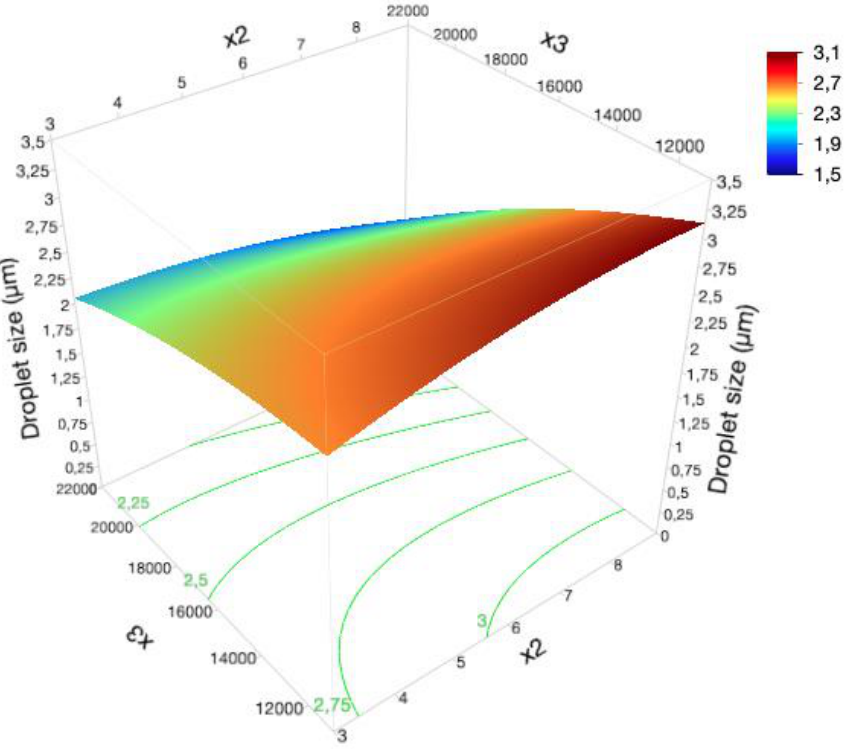
Figure 1. Response surface plot showing the effect of isopropyl myristate amount and homogenization rate interaction on droplet size response.